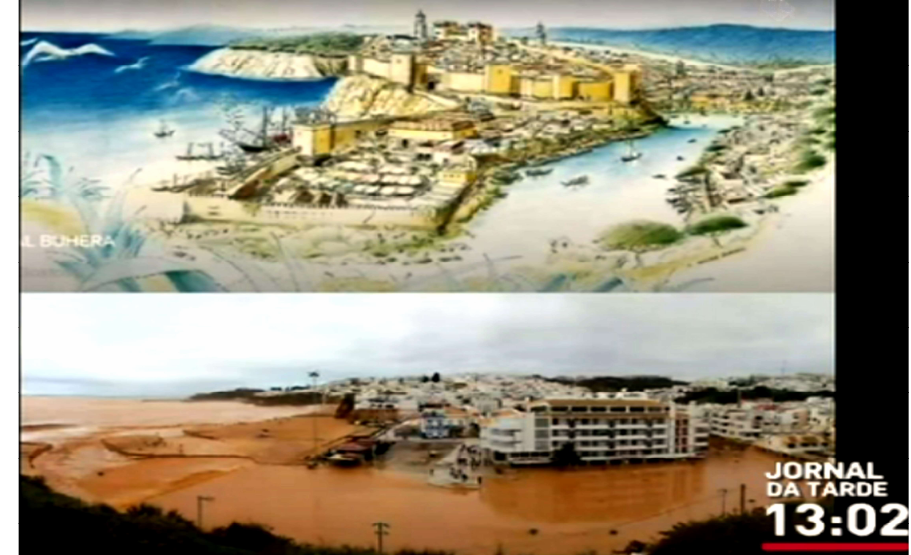
Figure 2. A representation of the medieval times city of Albufeira and a recent photo from the flash flood (obtained from the RTP TV channel during the news of 1 November 2015), showing that the buried river found its natural way to the Atlantic Ocean.